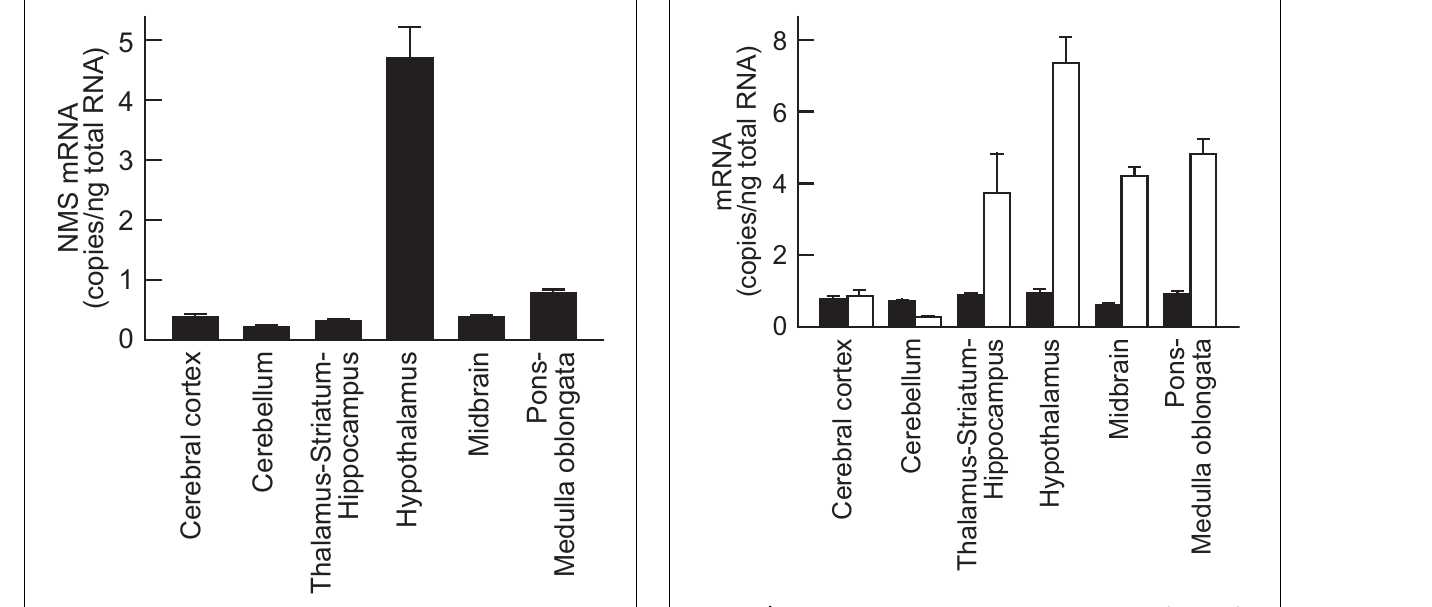
FIGURE 4 | Expression of neuromedin S (NMS) mRNA in rat brain. Rat NMS mRNA was quantified by quantitative reverse transcription– polymerase chain reaction analysis.The brains were sampled during the light period. Data represent means ± SEM of three rats.